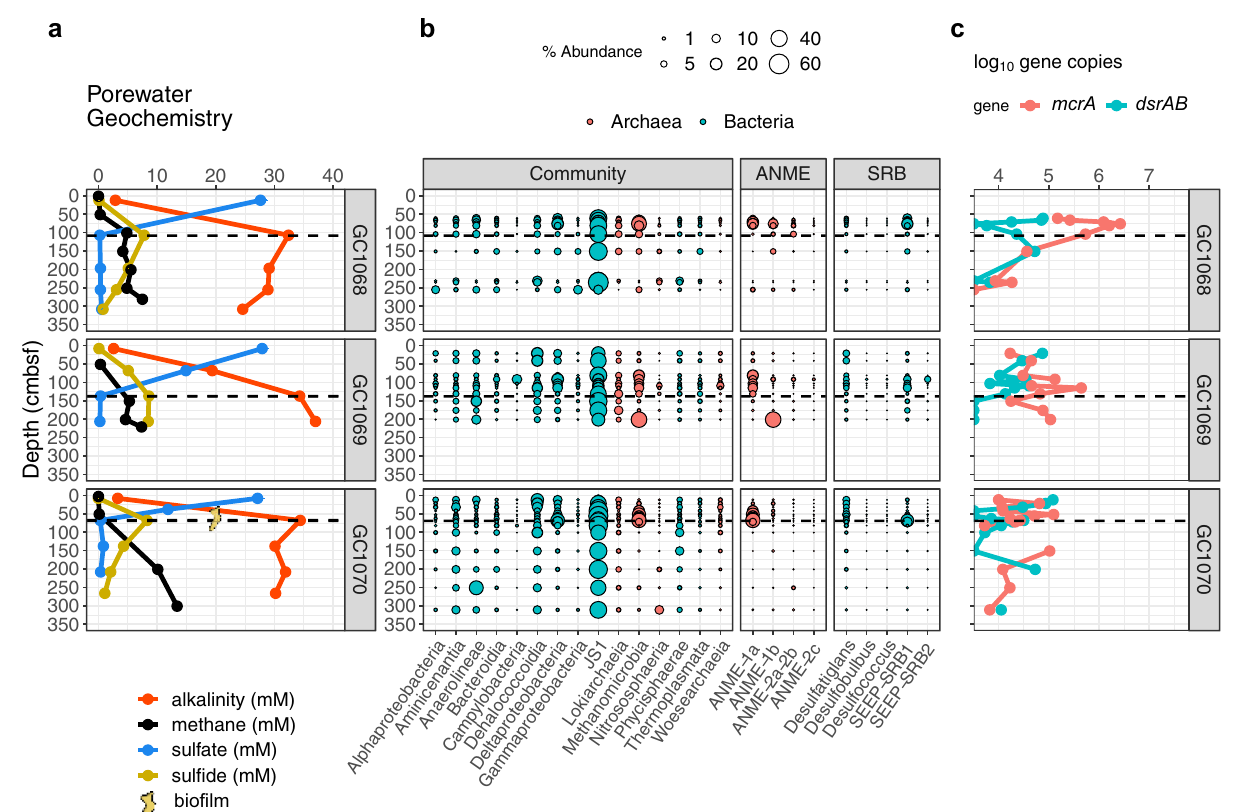
Fig. 3 Geochemical, microbial community, and gene abundance data from three cores at gas hydrate mound 5 showing steady-state sulfate-methane dynamics. Sulfate-methane transition depths in centimeters below sea fl oor are indicated by dashed lines. a shows methane concentrations and porewater sulfate, sul fi de, and alkalinity, and b indicates percent abundances of dominant bacterial and archaeal classes, dominant anaerobic methanotrophic archaeal (ANME) families, and sulfate-reducing bacterial (SRB) genera. c shows copy numbers of mcrA and dsrAB genes per gram bulk sediment, with values below the detectable limit (10 3 g − 1 ) along the margin of the panel. Macroscopic translucent-to-yellow bio fi lms, shown as yellow symbols in panel ( a ), were observed at 63 and 68 cm below sea fl oor in gravity core GC1070 (symbol size not to scale with depth